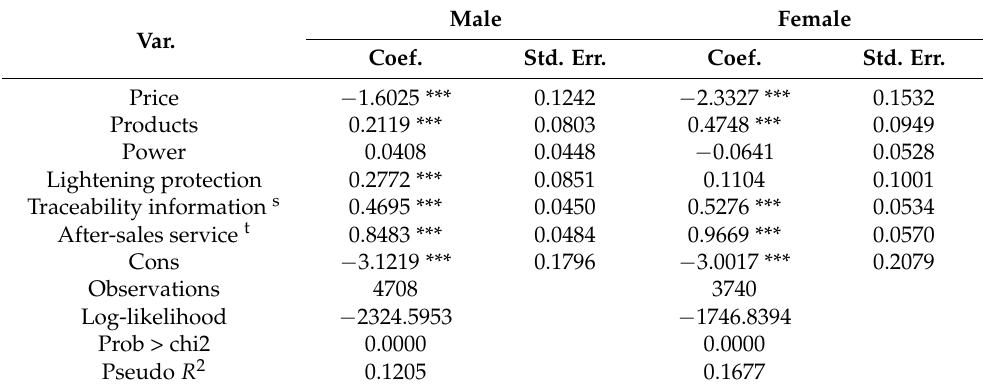
Table 10. Regression results by gender grouping.